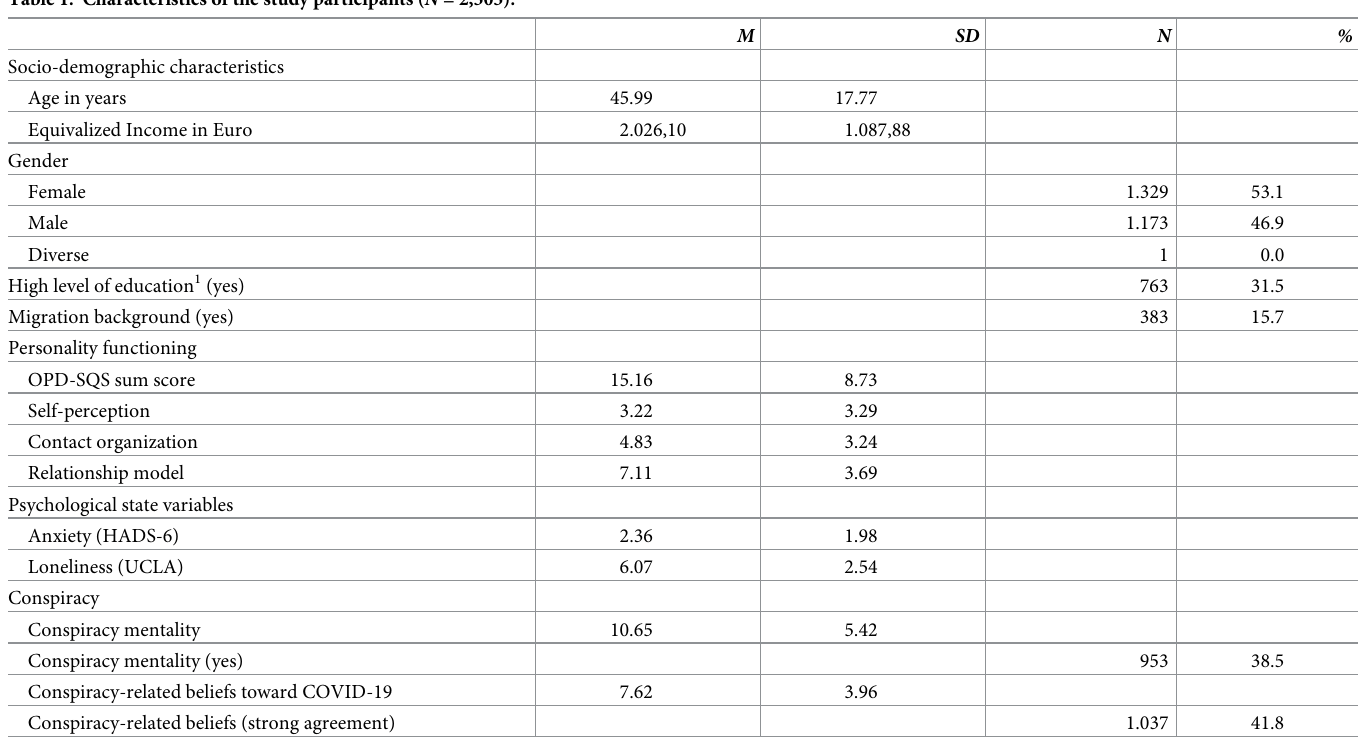
Table 1. Characteristics of the study participants ( N =